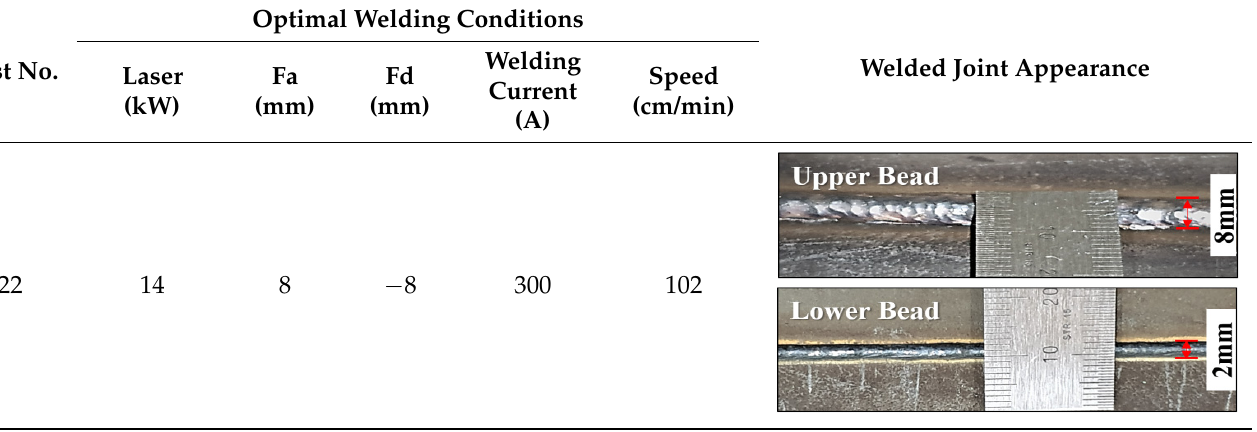
Table 5. Optimal welding conditions and welded joint appearance.